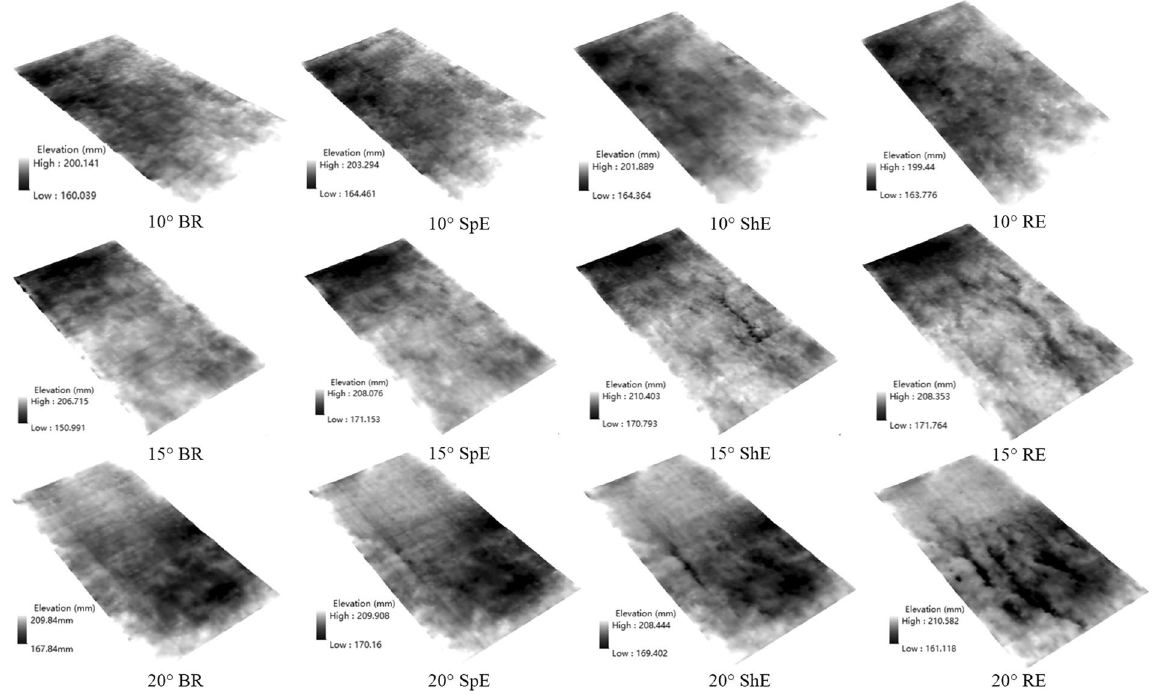
Figure 1. Change of micro-topography at different water erosive stages. Note: The BR indicates before rain, SpE, ShE and RE indicate splash erosion, sheet erosion and rill erosion, respectively. The same as